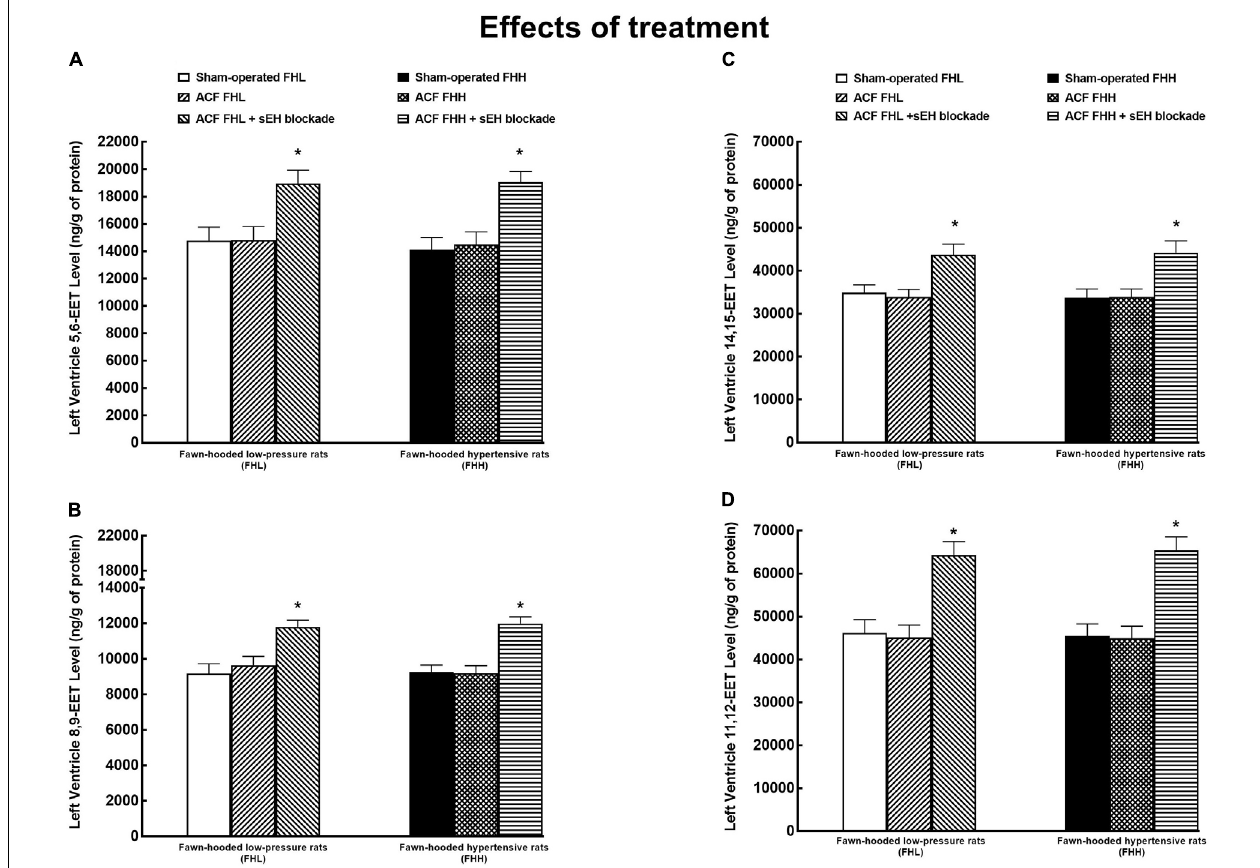
FIGURE 9 | Left ventricle tissue 5,6-epoxyeicosatrienoic acid (EET) (A) , 8,9-EET (B) , 14,15-EET (C) , and renal 11,12-EET (D) concentrations in FHL and hypertensive (FHH) rats. The data for the groups of either strain that were sham-operated or with ACF or ACF rats treated with a sEH inhibitor. ∗ P < 0.05 compared with sham-operated